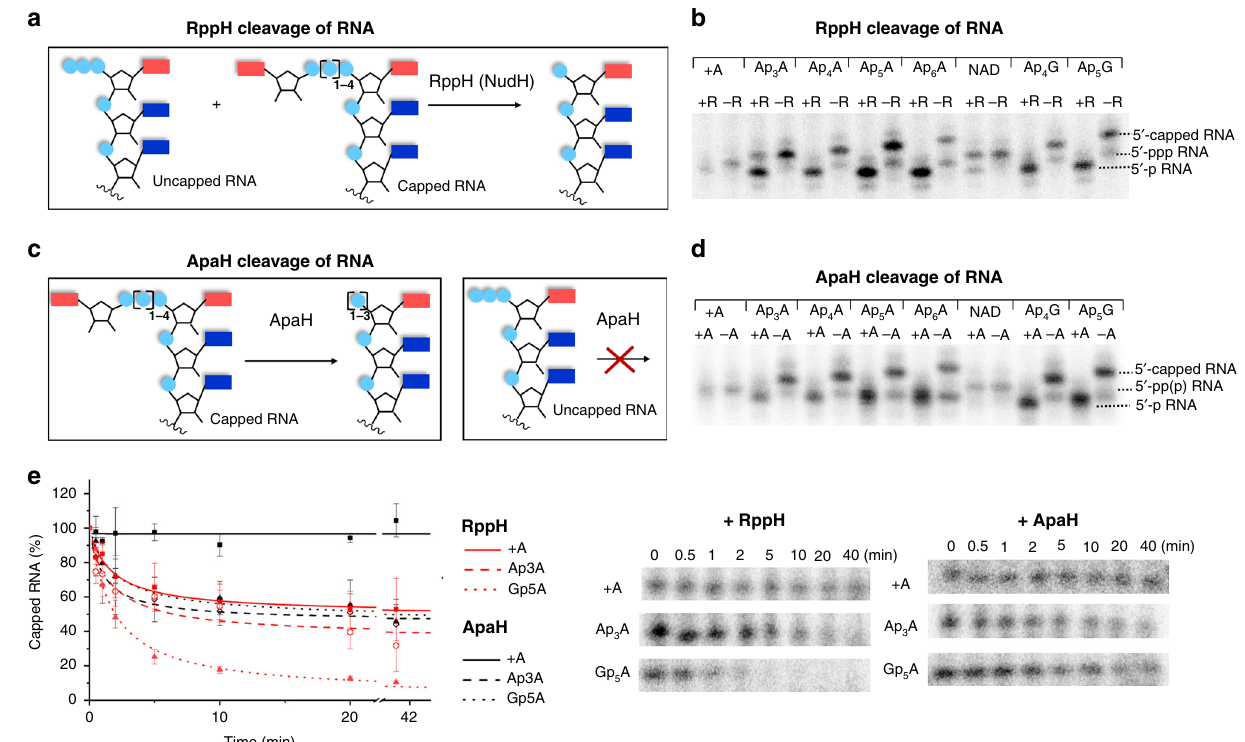
Fig. 3 RppH and ApaH cleavage of Np n N-capped RNA ( 32 P labeled). a Scheme showing the cleavage of capped and uncapped RNA (in vitro transcripted with T7 RNAP) using RppH. b PAGE (12%) analysis of the ( α - 32 P GTP labeled) in vitro transcribed RNA (35 nt) treated with RppH ( + R) or without RppH ( − R; all the experiments were performed in triplicates). c Scheme showing the cleavage of capped and uncapped RNA (in vitro transcripted with T7 RNAP) using ApaH. d PAGE (12%) analysis of in vitro transcribed RNA (35 nt) treated with ApaH ( + A) or without ApaH ( − A; all the experiments were performed in triplicates). e Kinetic studies of RppH (red curves) and ApaH (black curves) cleavage of 5 ′ -ppp RNA (solid line), Ap 3 A-RNA (dashed line), and Gp 5 A- RNA (dotted line; 35 nt) stopped after 30 s, 1, 2, 5, 10, 20, and 40 min and analyzed by PAGE (12%). All experiments were performed in triplicates and calculated as average values. Error bars indicate standard deviations. Source data are provided in the Source Data fi